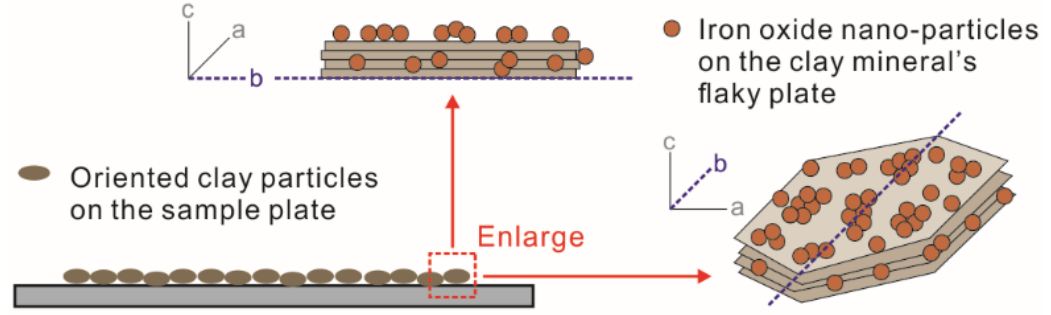
Figure 6. Occurrence types of iron oxide in the clay particles on the preferred orientation specimens.